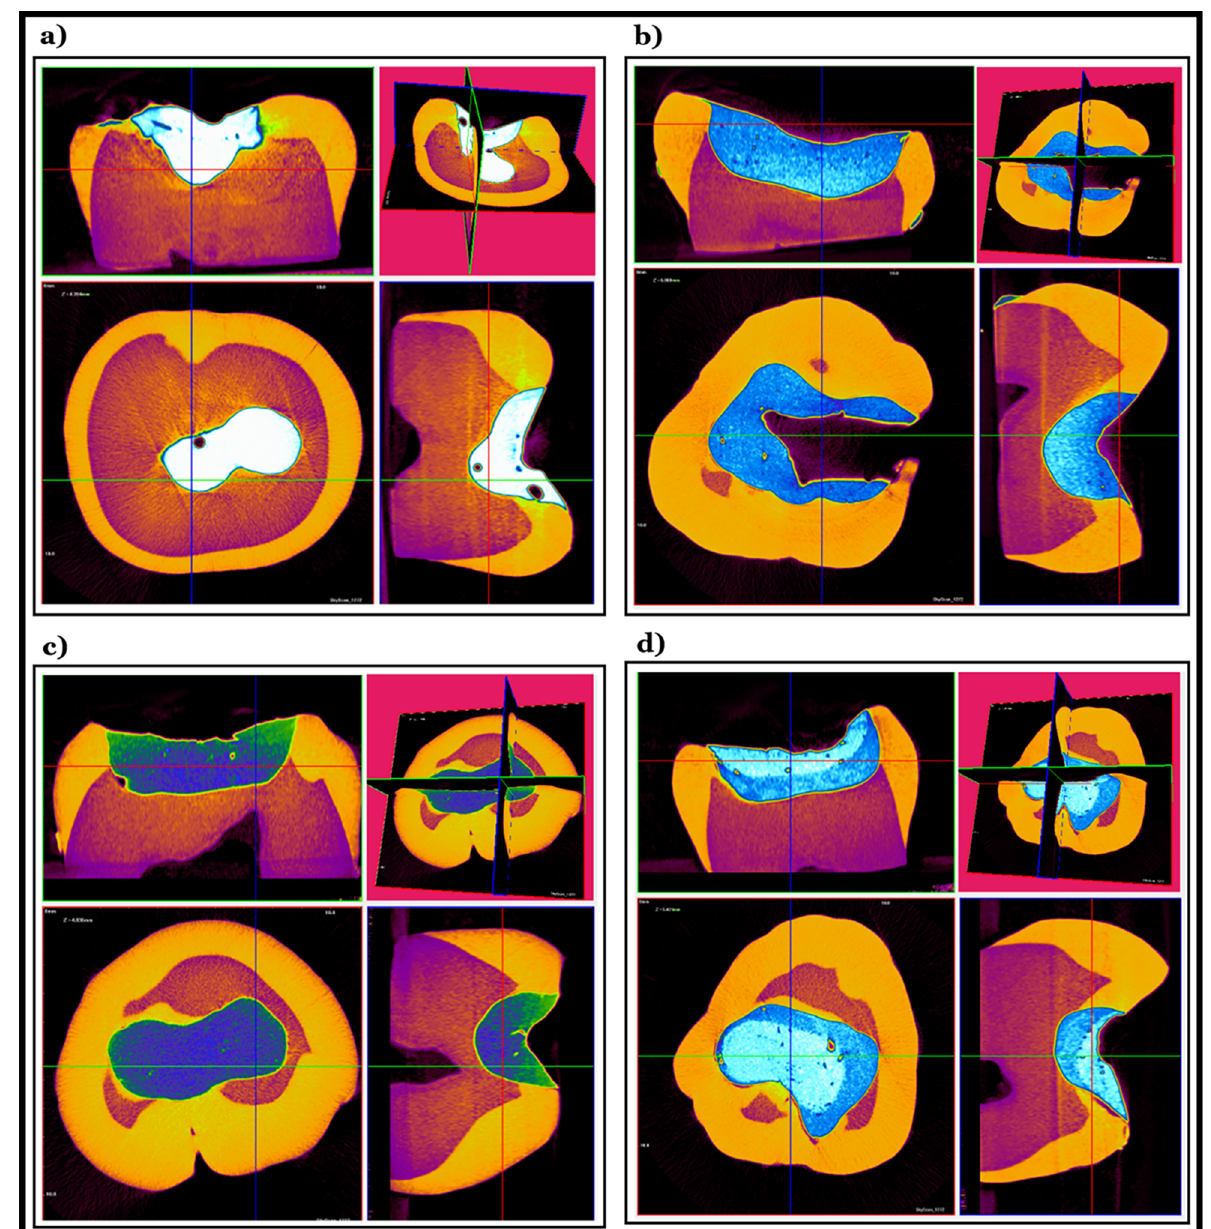
Figure 4. µCT photographs of the restored teeth: ( a ) Adper Easy Bond™+Filtek™ Bulk Fill (3M™ ESPE, St. Paul,